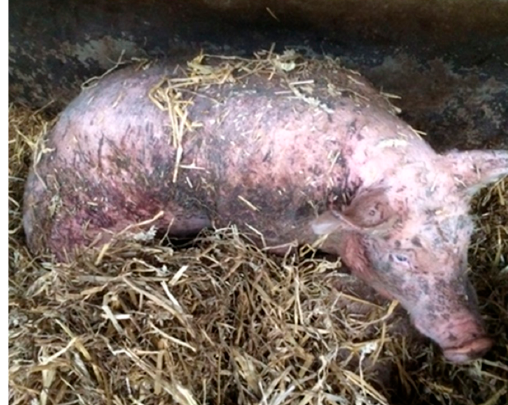
Figure 3. Victim found while still alive (here in recovery pen). Dark patches on the skin are, with the exception of the face, skin lesions as a result of receiving